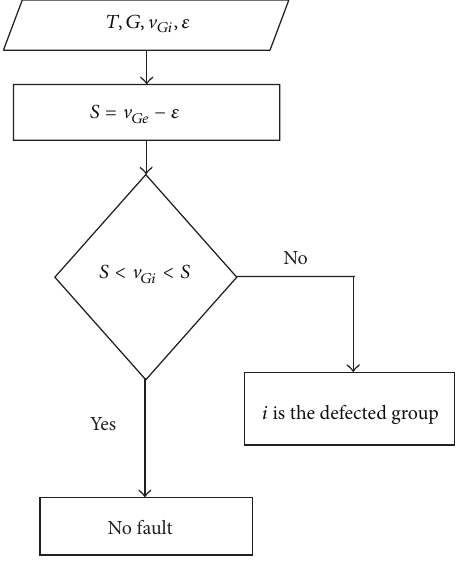
Figure 2: Fault detection algorithm.